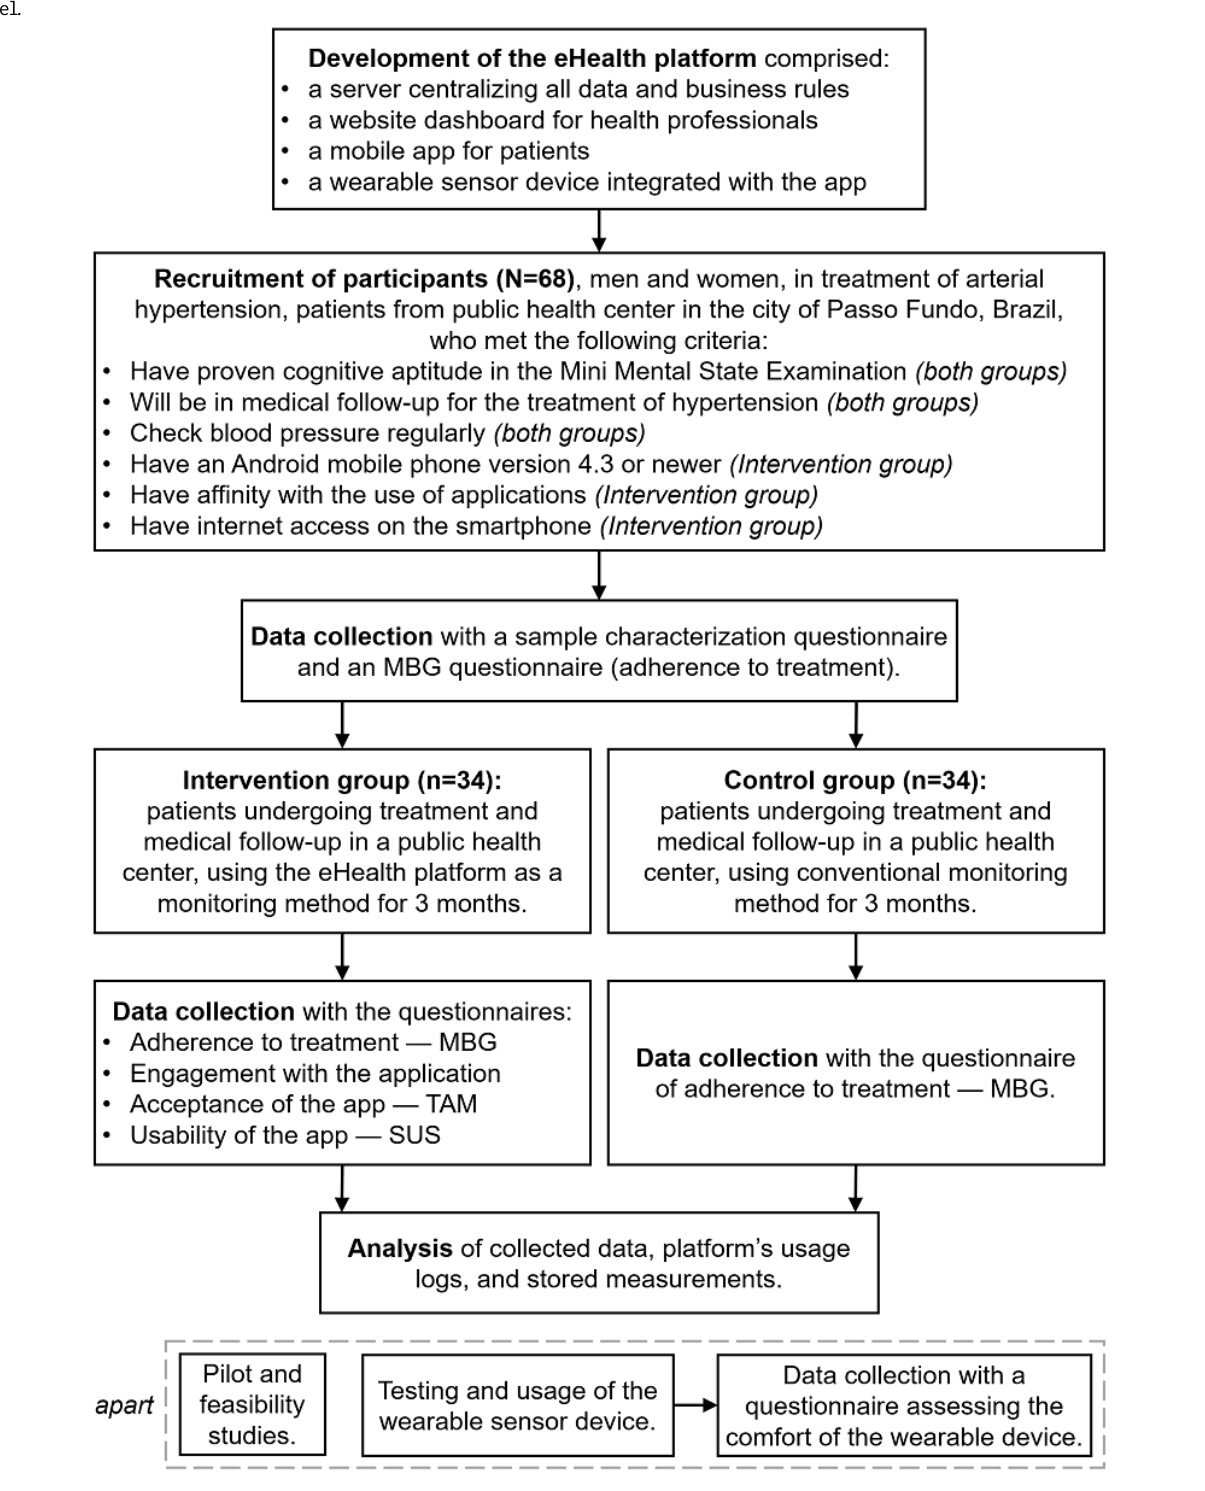
Figure 2. Trial procedure flowchart. eHealth: electronic health; MBG: Martín-Bayarre-Grau; SUS: System Usability Scale; TAM: technology acceptance